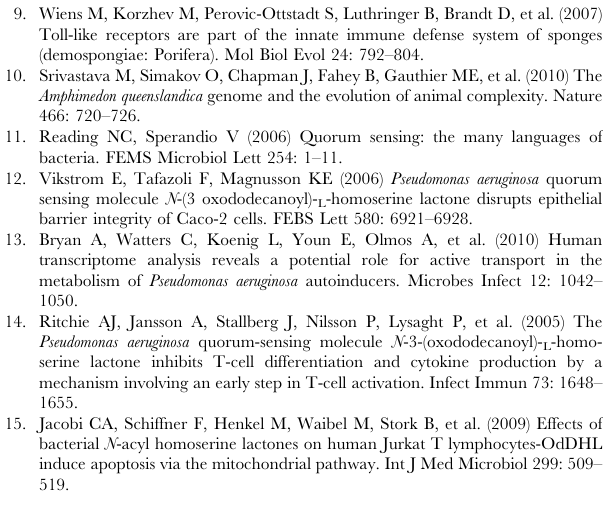
Figure S1 Effect of N -3-oxododecanoyl- L -homoserine lactone (3-oxo-C 12 -HSL) on the viability of Suberites domuncula cells. Histogram of the optical density of the cell lysate at 540 nm corresponding to the amount of formazan formed by the alive S. domuncula cells. Sponge cells were cultured and then stimulated with 10 2 6 (soft grey), 10 2 5 (medium grey) and 10 2 4 M (dark grey) 3-oxo-C 12 -HSL, with 1% DMSO (v: v) (white) and with only culture medium (black) for 24 h and 48 h. Table S1 Complementary information regarding the proteomic